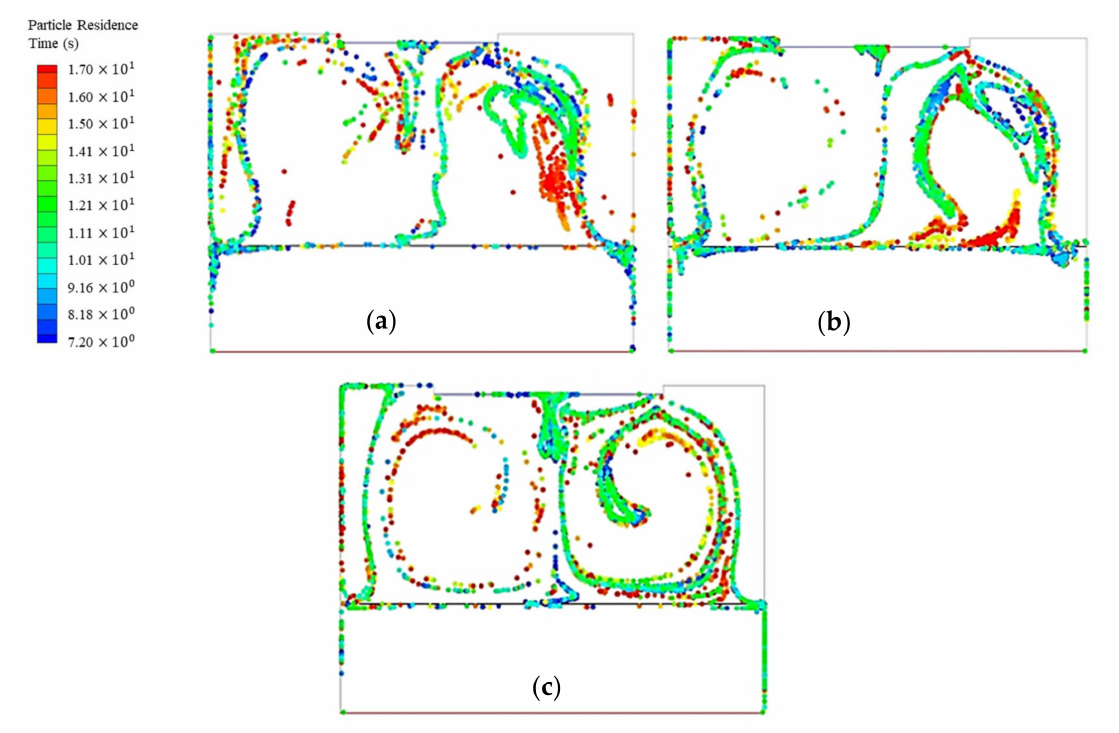
Figure 13. Inclusions distribution with different filling ratio ( a ) 0.38 ( b ) 0.46 and ( c ) 0.54. During the ESR process with different filling ratio, the removal ratio of inclusions was counted separately in Figure 14. For the 50 µ m inclusions, the removal ratio reaches more than 95% for three different filling ratio. When the filling ratio is 0.46, the inclusions removal ratio is the highest. For the 30 µ m inclusions, they accumulated at the bottom of the liquid-metal pool when the filling ratio is 0.46, resulting in a significant decrease in the inclusions removal ratio, but the removal ratio is higher when the filling ratio is 0.54 than when itis 0.46. For the 10 µ m inclusions, the removal ratio reaches the maximum value, 97%, with a filling ratio of 0.54.